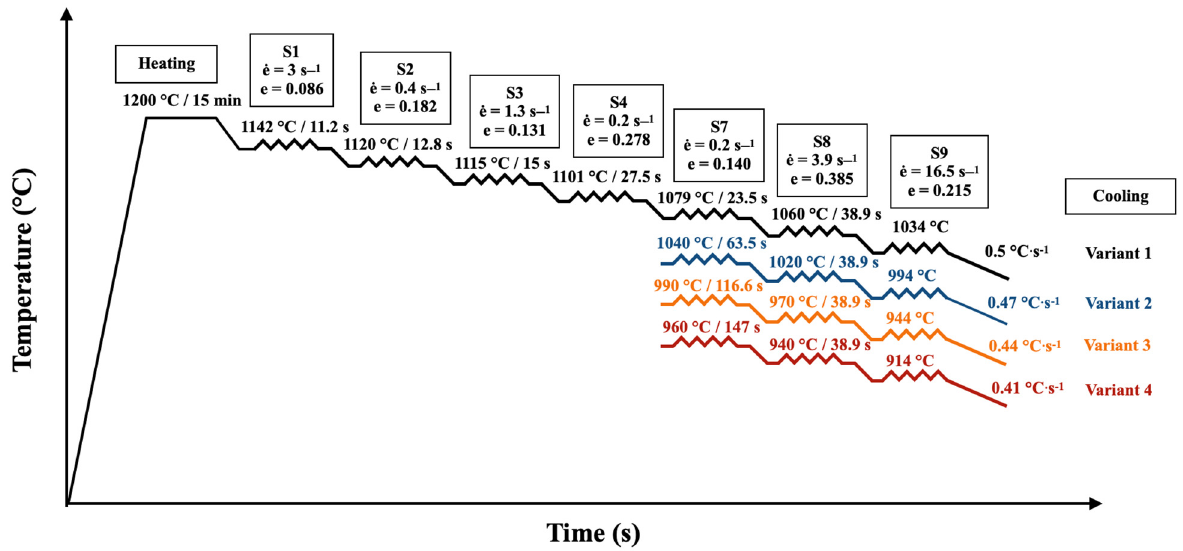
Figure 11. Schematic illustration of PSCTs ( represents an individual pass).